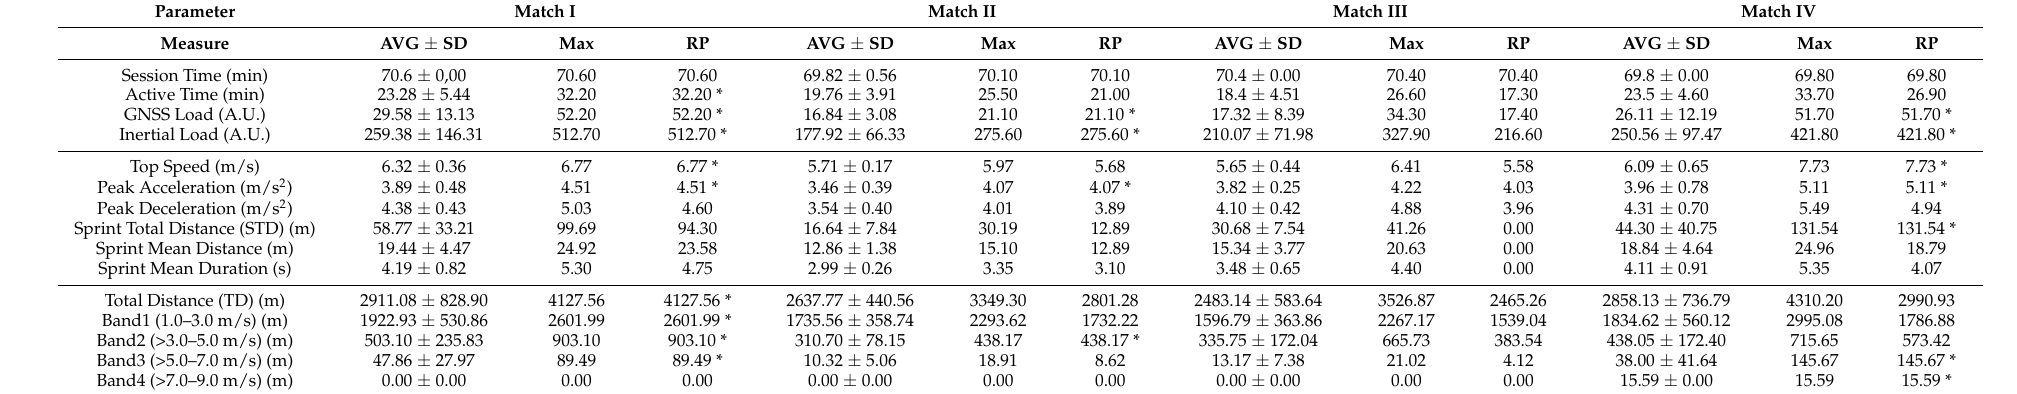
Table 2. The key performance indicators based on the match analysis using GNSS tracking technology (only field players) * indicates which results achieved by representative player—RP were the highest among the entire team; A.U.—arbitrary